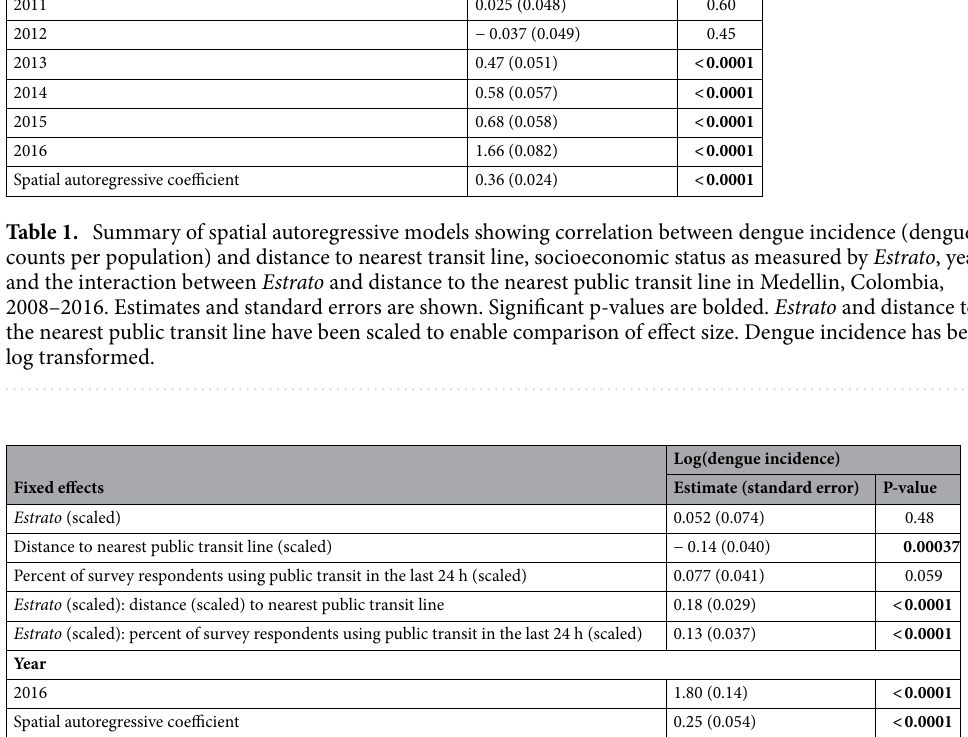
Table 2. Summary of spatial autoregressive models for data restricted to 2011 and 2016 showing correlation between dengue incidence (dengue counts per population) and distance to nearest transit line, socioeconomic status as measured by Estrato , year, and the interaction between Estrato and distance to the nearest public transit line and Estrato and percent of survey respondents reporting using public transit in the last 24 h. Estimates and standard errors are shown. Significant p-values are bolded. Estrato, percent of survey respondents using public transit in the last 24 h, and distance to the nearest public transit line have been scaled to enable comparison of effect size. Dengue incidence has been log